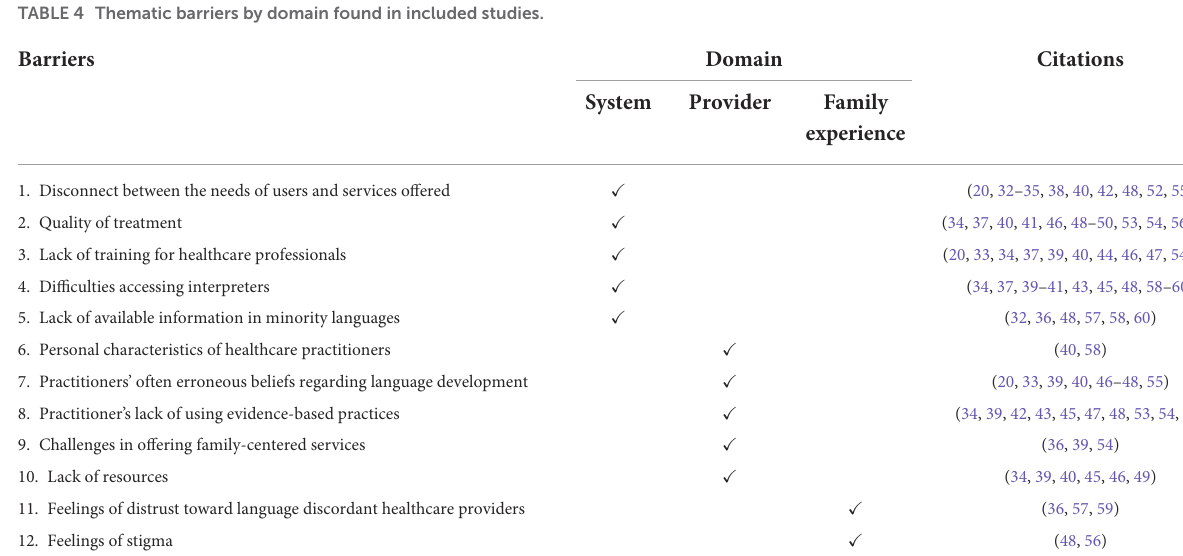
TABLE 4 Thematic barriers by domain found in included